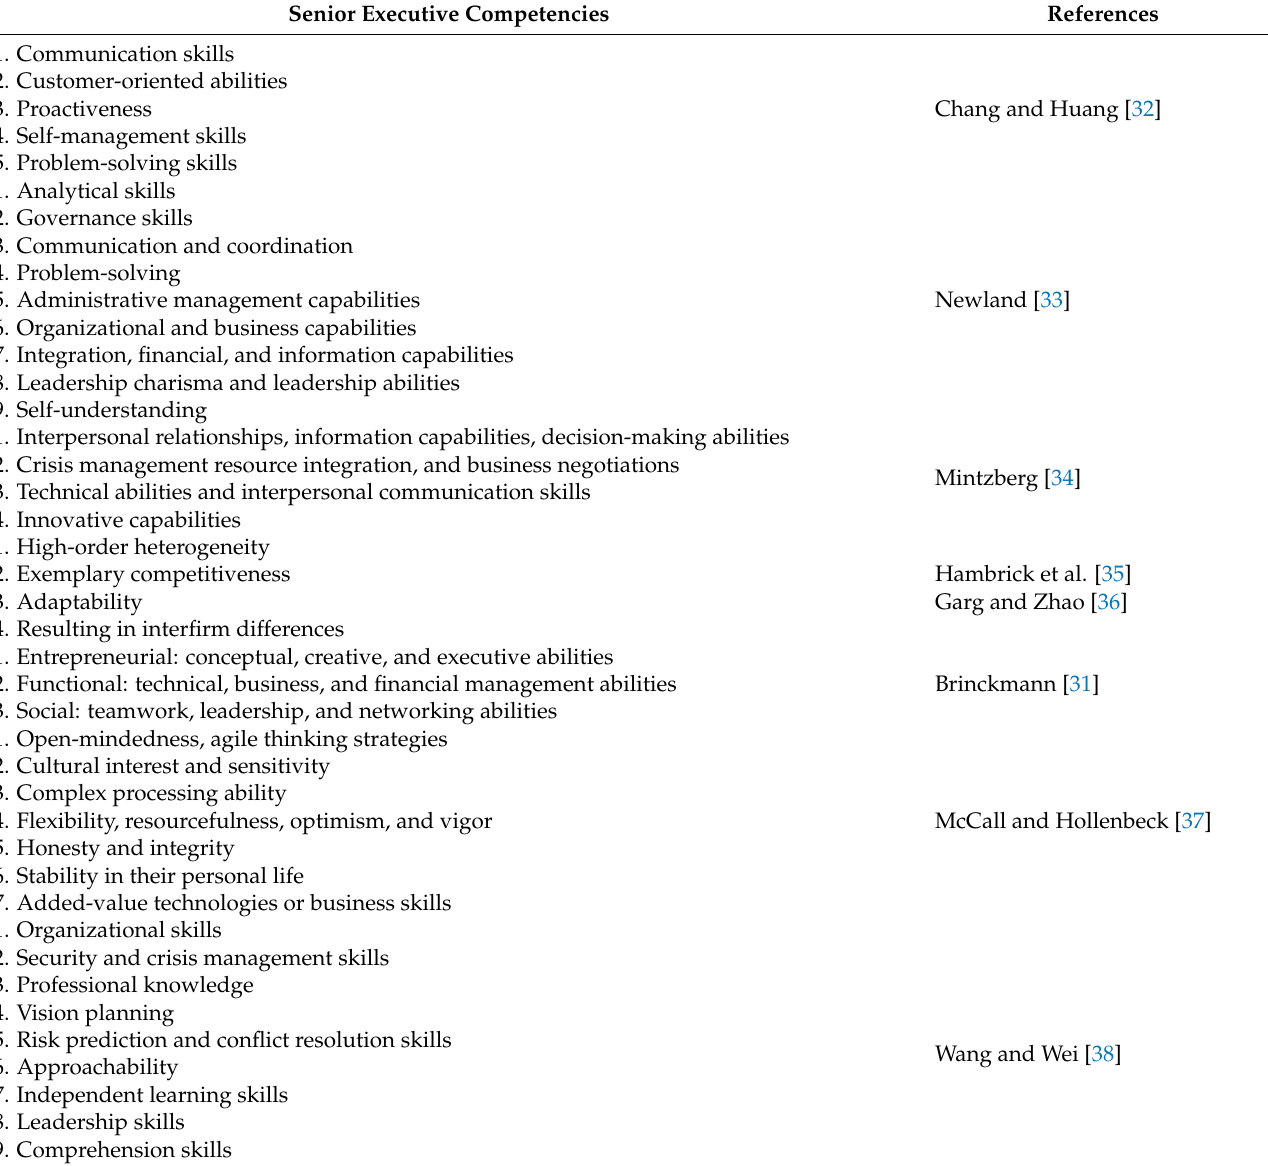
Table 5. Senior executive